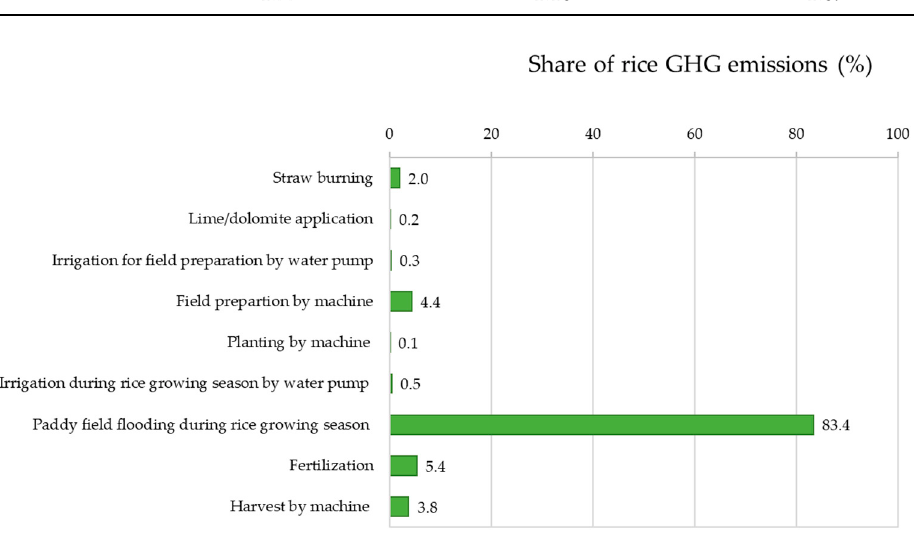
Figure 4 . The contribution of GHG emissions by rice cultivation activities. Figure 4. The contribution of GHG emissions by rice cultivation